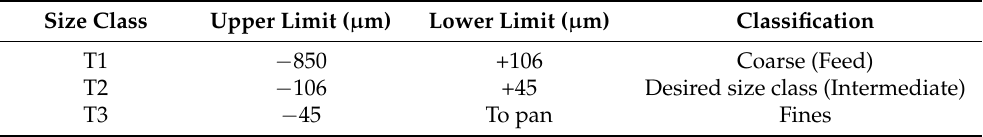
Table 5. Particle size range used for A.R.